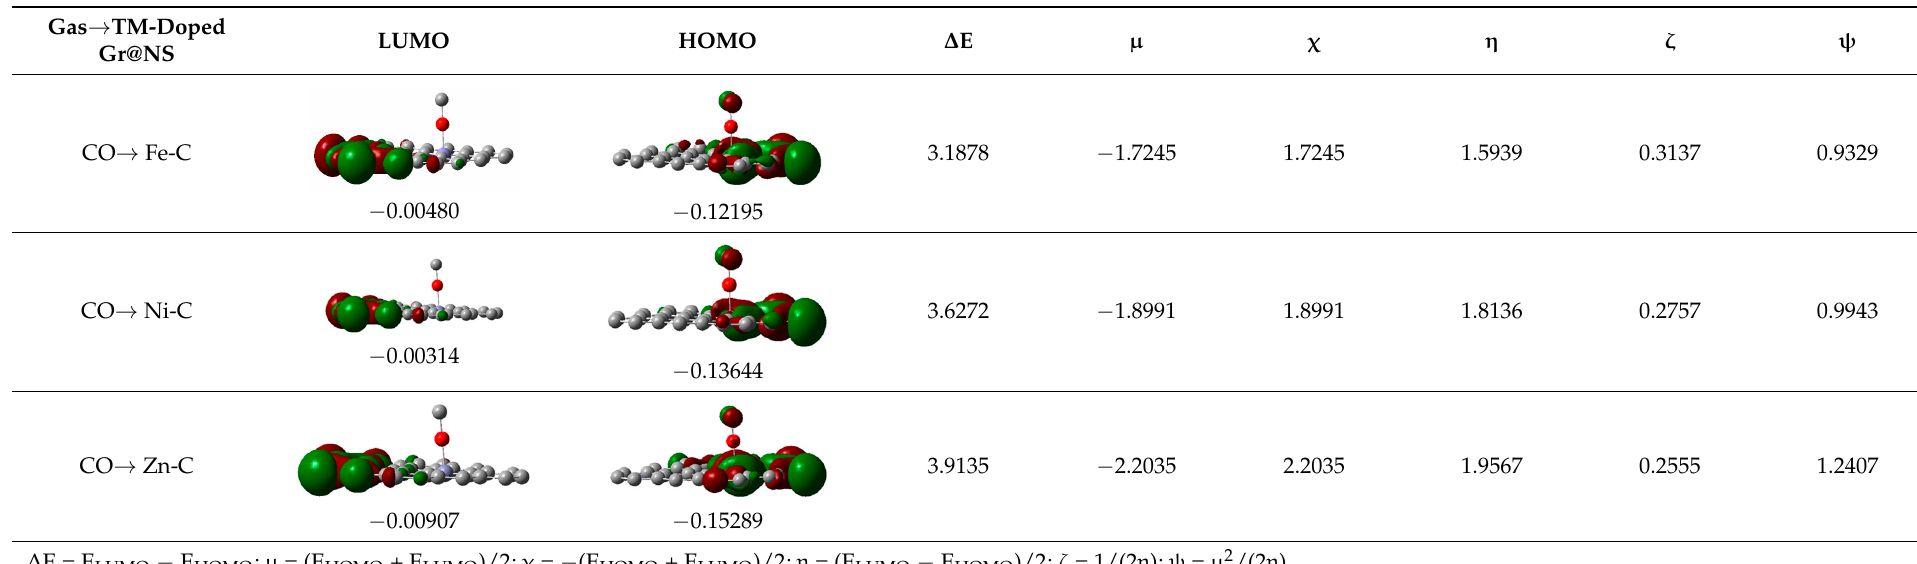
Table 4. The LUMO (a.u.), HOMO (a.u.), band energy gap ( ∆ E/eV) and other parameters (eV) for adsorption of CO as a toxic gas on TM (Fe, Ni, Zn)-doped